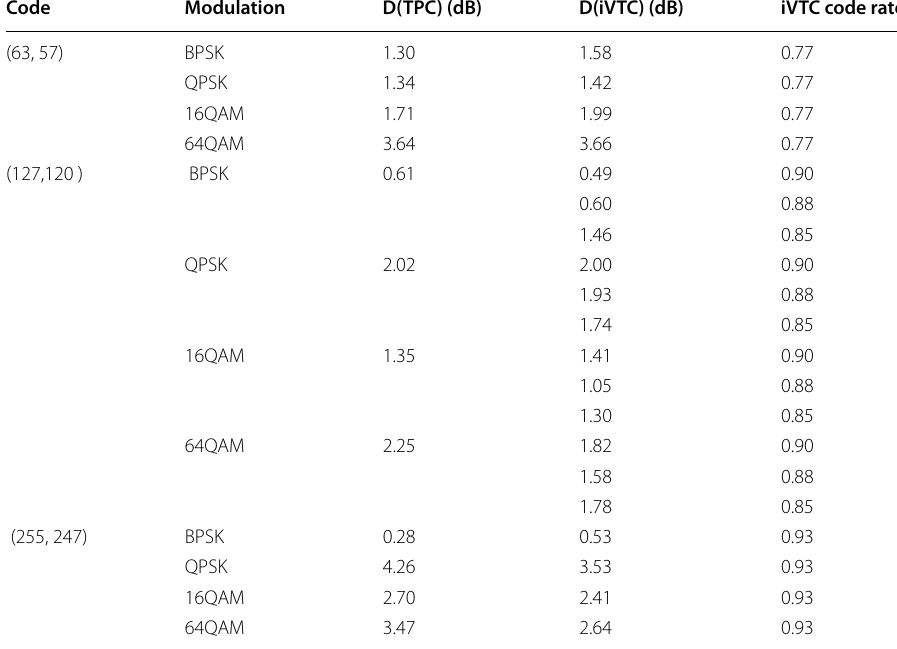
a The (63, 57), (127, 120) and (255, 247)TPCs have fixed code rates of 0.82, 0.89 and 0.94, respectively. D(TPC), D(iVTC) in the table represent, the distance to capacity for the TPC and the iVTC in dB, respectively